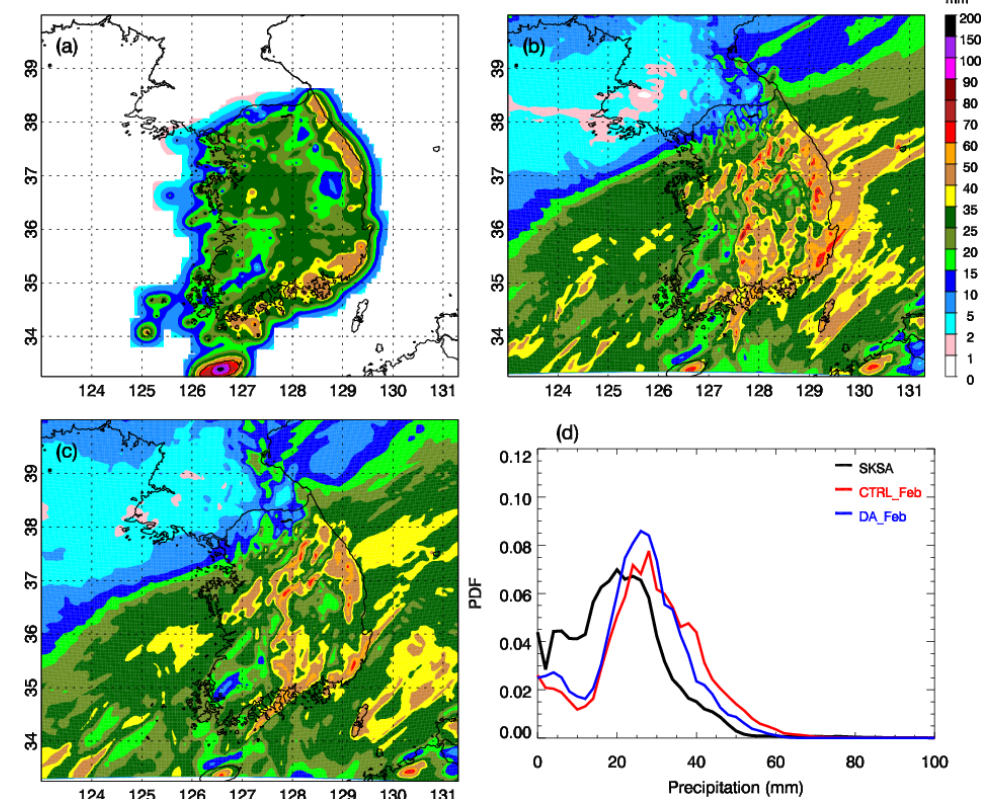
Figure 14. The 24h accumulated precipitation (mm) from (a) South Korean Surface Analysis, (b) CTRL_Feb, and (c) DA_Feb from 21:00UTC 27 February to 21:00UTC 28 February 2018, and (d) the probability density function of 24h accumulated